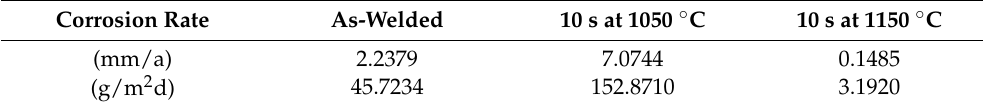
Table 3. Average corrosion rate of each